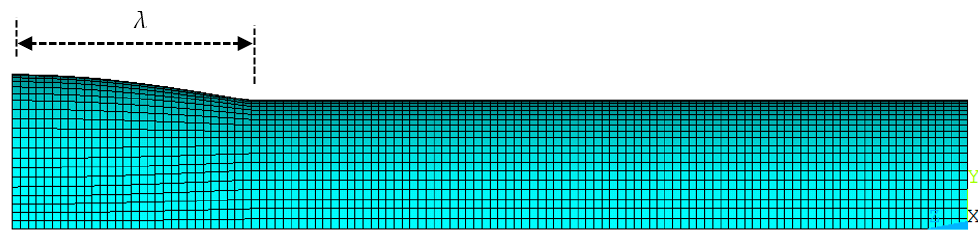
Figure 3. Sample of initial imperfection in the axial direction (factor = 100). Table 2. Comparison of FEM calculation and experiment results from [6].